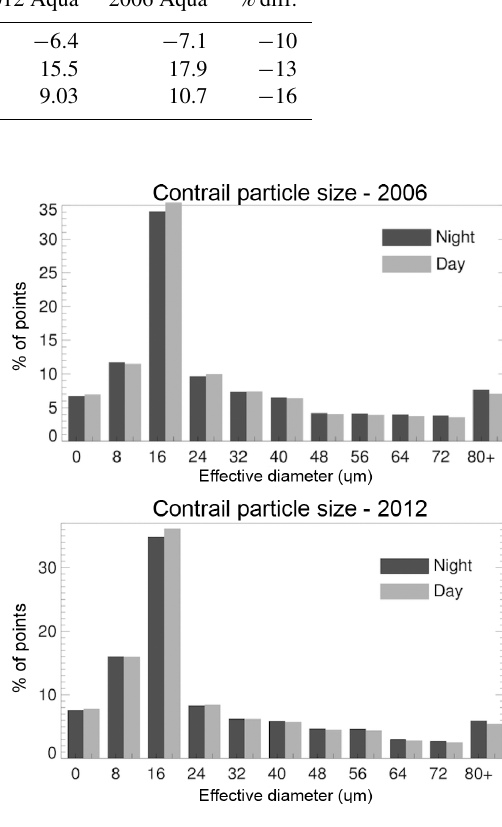
Figure 12. Histograms of retrieved contrail D e (in microns) com- puted from 2006 and 2012 Terra MODIS